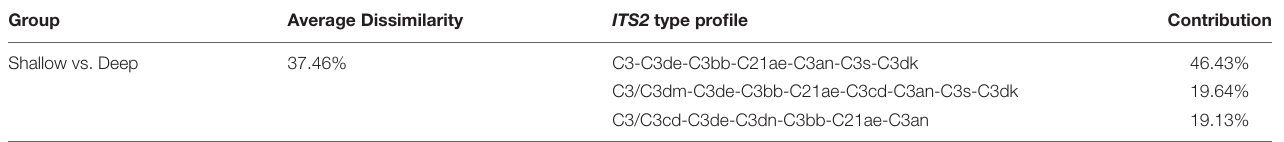
TABLE 4 | Similarity percentage (SIMPER) test results. Group Average Dissimilarity ITS2 type profile Contribution Shallow vs.